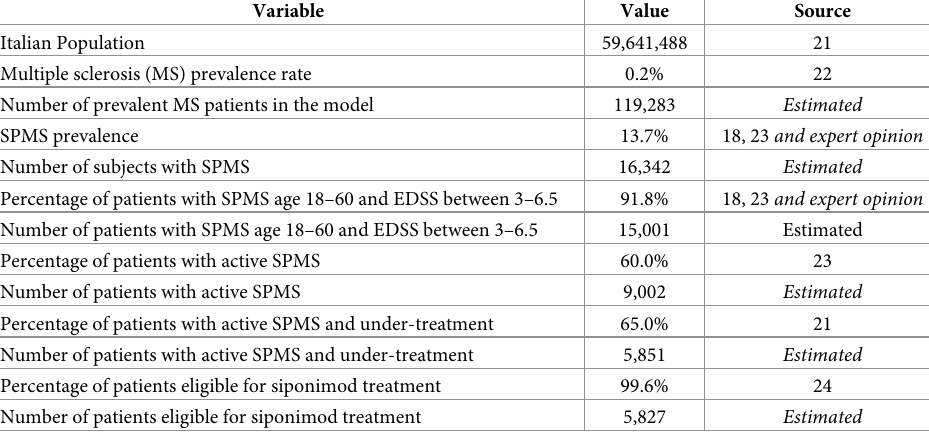
Table 4. Epidemiological data on study